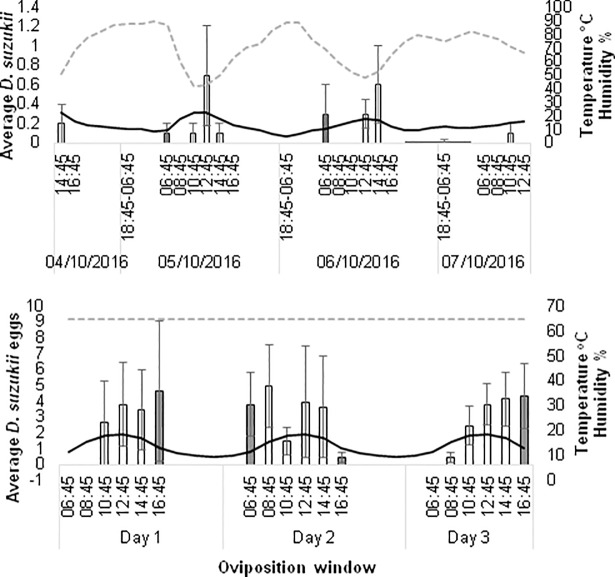
Average D. suzukii oviposition of wild and laboratory strains under October conditions within the field and laboratory.Average reproductive oviposition (+SE) of (a) wild D. suzukii in the field and (b) average oviposition (+SE) of laboratory strains in recreated October conditions within the laboratory (bars) in 2 hour ‘oviposition windows’ over three days. Average temperature (black solid line) and relative humidity (RH) (dashed grey line at x 0.5) cycled through-out. Note that relative humidity was kept constant at 65% in laboratory assays. Light is indicated by the colour of average D. suzukii bars. Black = darkness, grey = half-light and white = light.